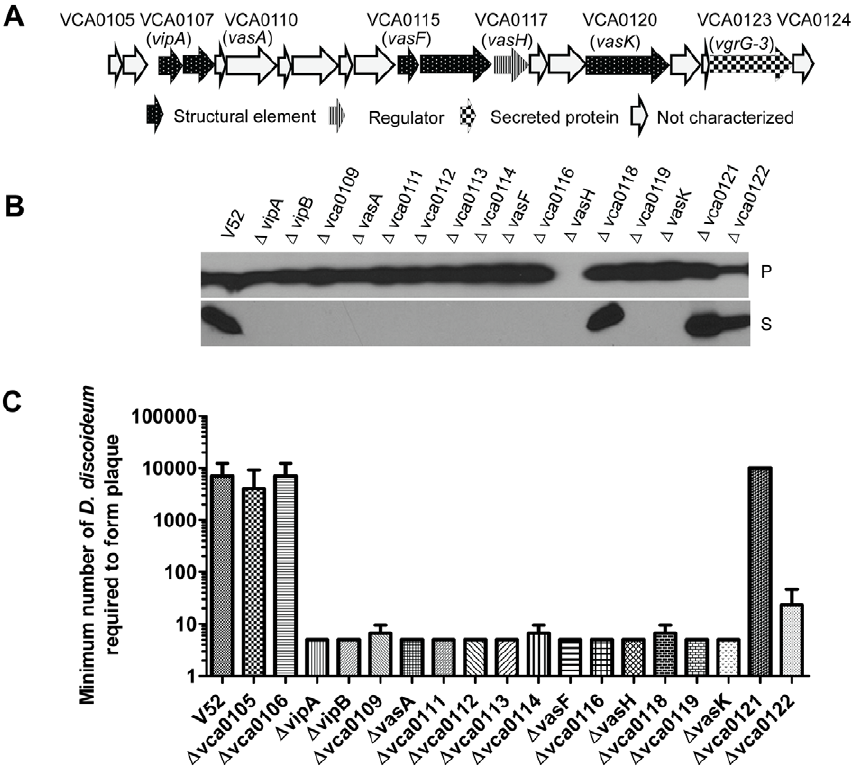
Figure 1. Characterization of deletion mutants in V.cholerae T6SS locus. (A) Schematic representation of genes organisation in V. cholerae T6SS locus. Genes that have been characterized were represented by arrows filled with different patterns and genes that have not been characterized were shown with empty arrows. (B) Hcp expression in bacterial pellet (P) and secretion in culture supernatant (S) in different T6SS deletion mutants were examined by western blot with anti-Hcp serum. (C) D. discoideum plaque formation assay for individual T6SS deletion mutant. The minimum number of Dictyostelium amoebae cells required for plaque formation on the lawns of V. cholerae wild type or mutants was shown.